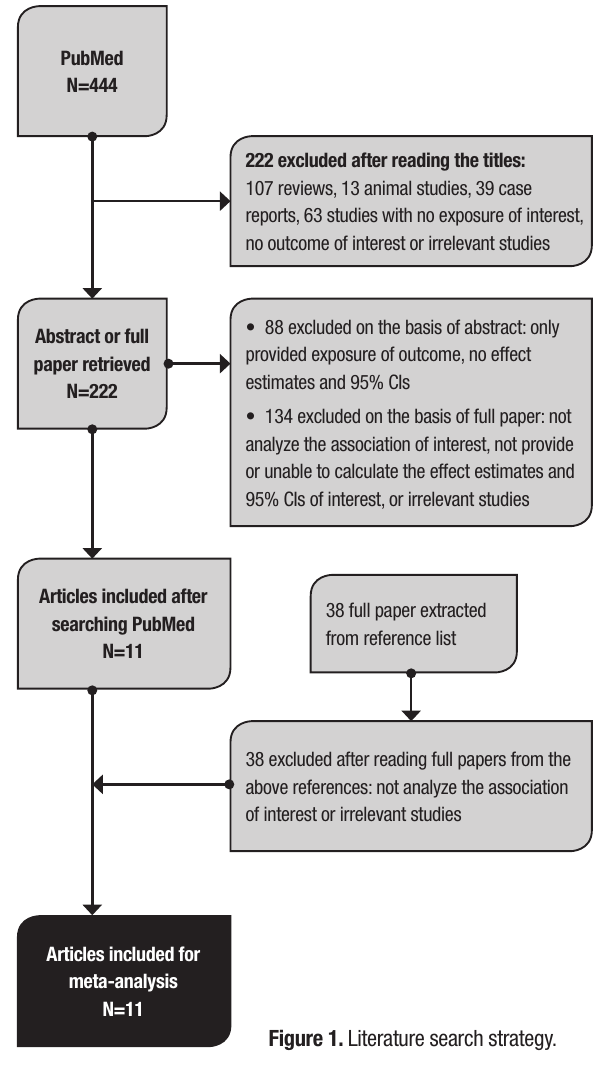
Figure 1. Literature search